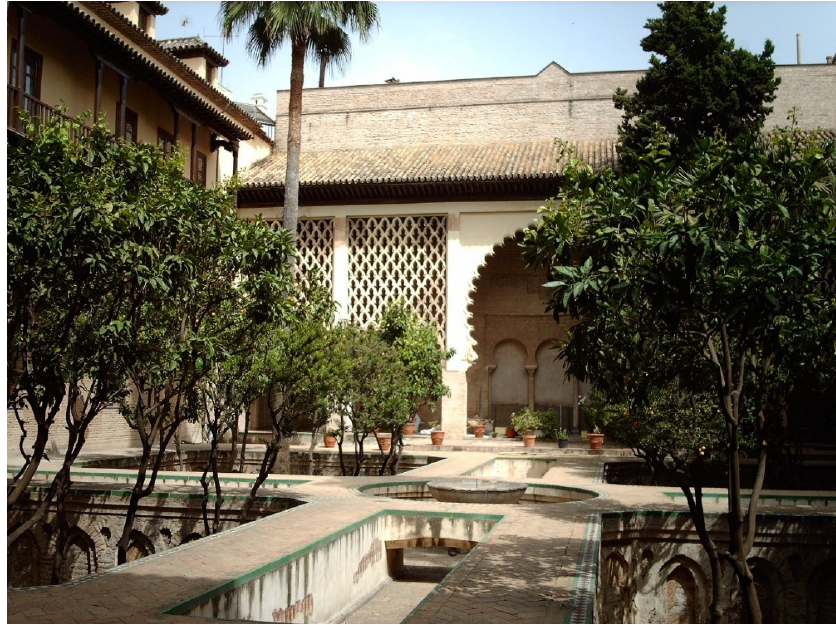
Figure 12. View of the courtyard of the former Casa de Contratación (Reales Alcázares de Sevilla). Photo took by author.